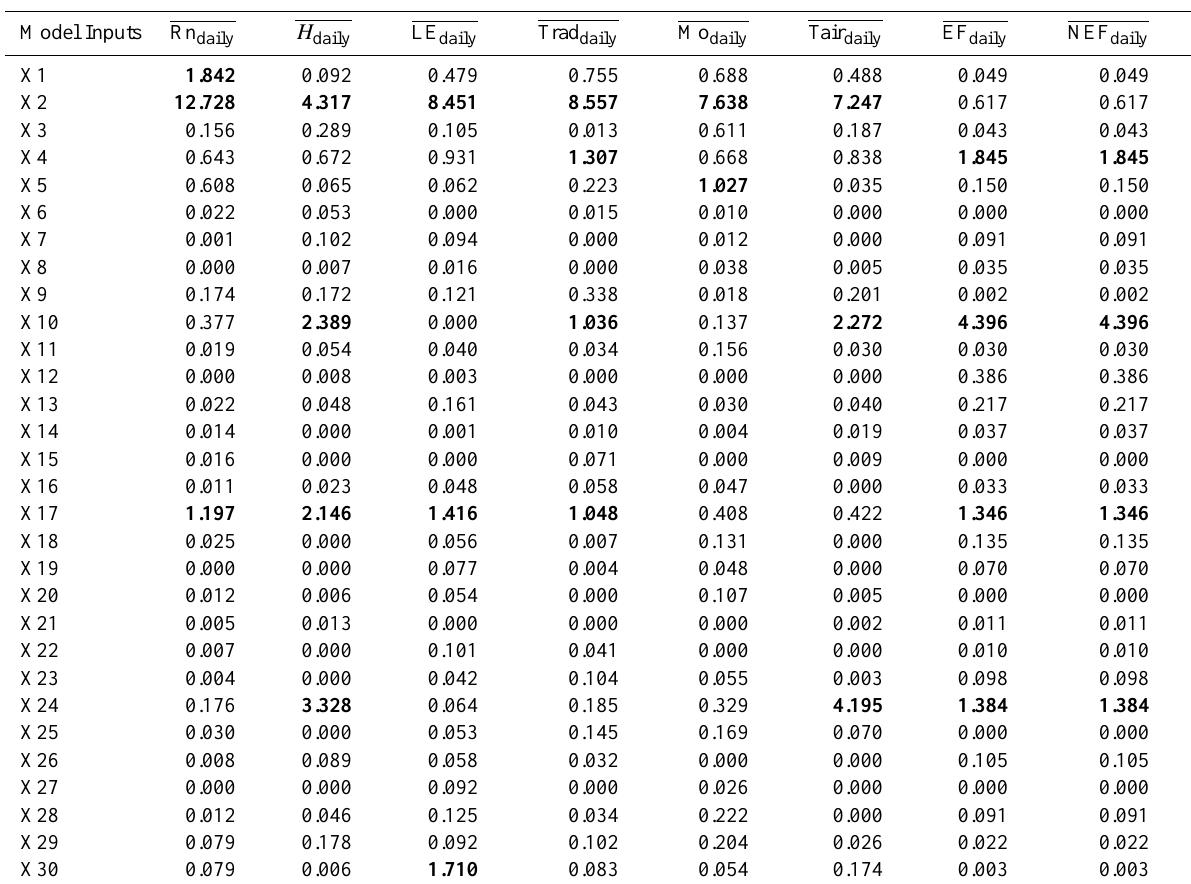
Table 3. Summarised statistics concerning the emulator accuracy evaluation for the different SimSphere model outputs examined in our study. Bold font highlights the roughness values of the model inputs with values greater than 1.0. Rows X1 to X30 show roughness values for the different model outputs examined (for normal and uniform